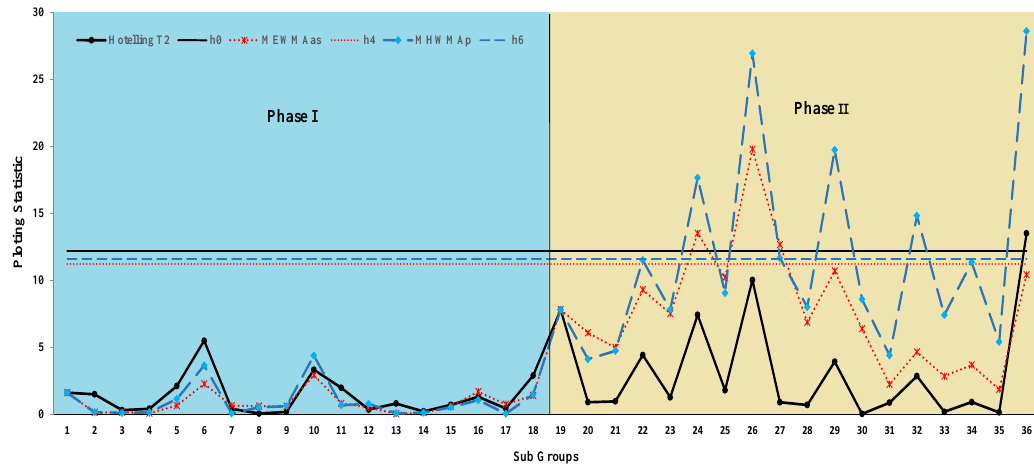
Figure 9. Comparison of proposed and existing chart under the target archery dataset.